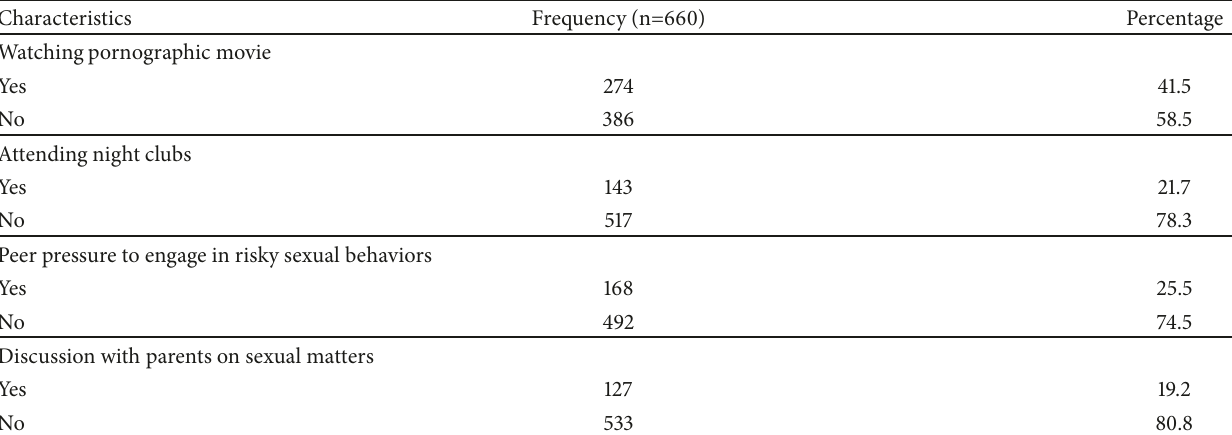
Table 2: Factors influencing acquirement of risky sexual behavior among Jimma University students, April, 2016.